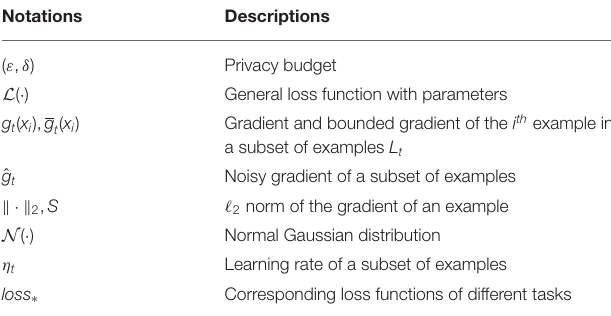
TABLE 1 | Notations and